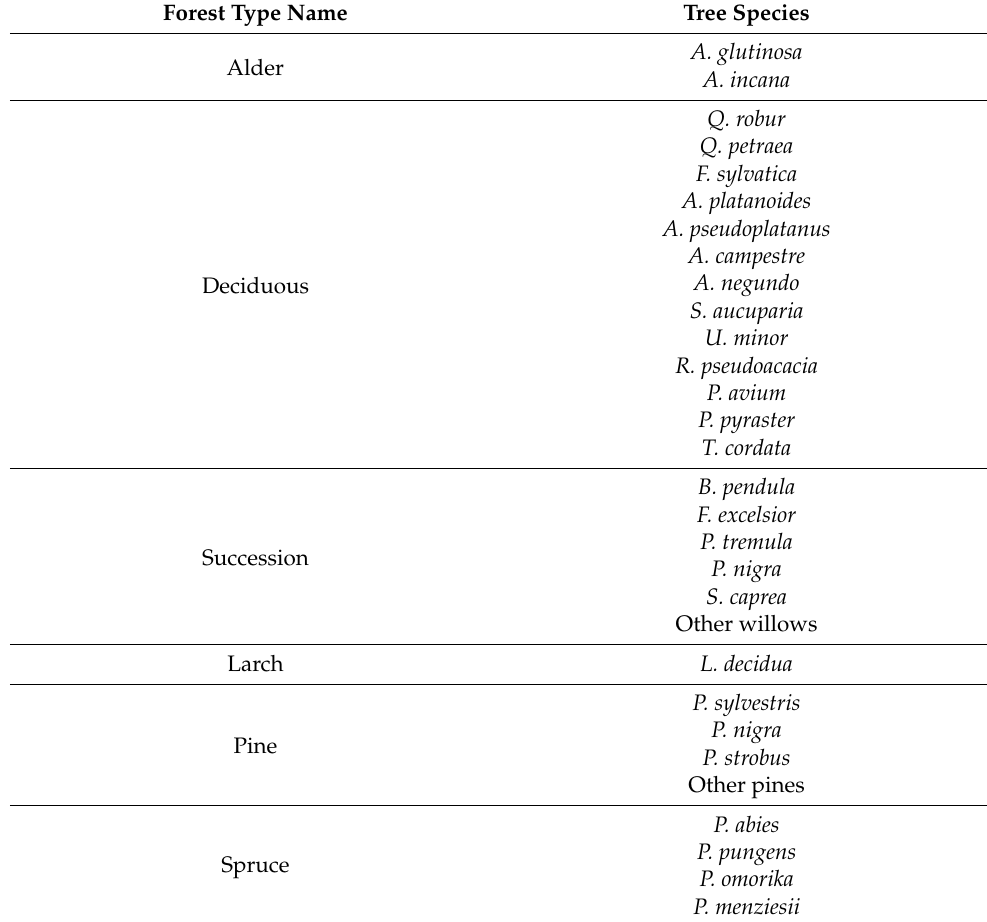
Table A2. Assignment of individual tree species to the defined categories of forest types.